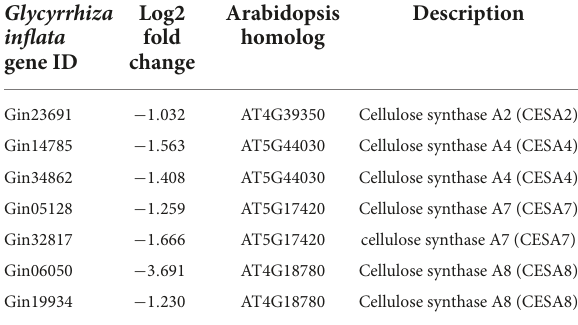
TABLE 2 Cellulose synthase A ( CESA ) genes identified in DEGs.